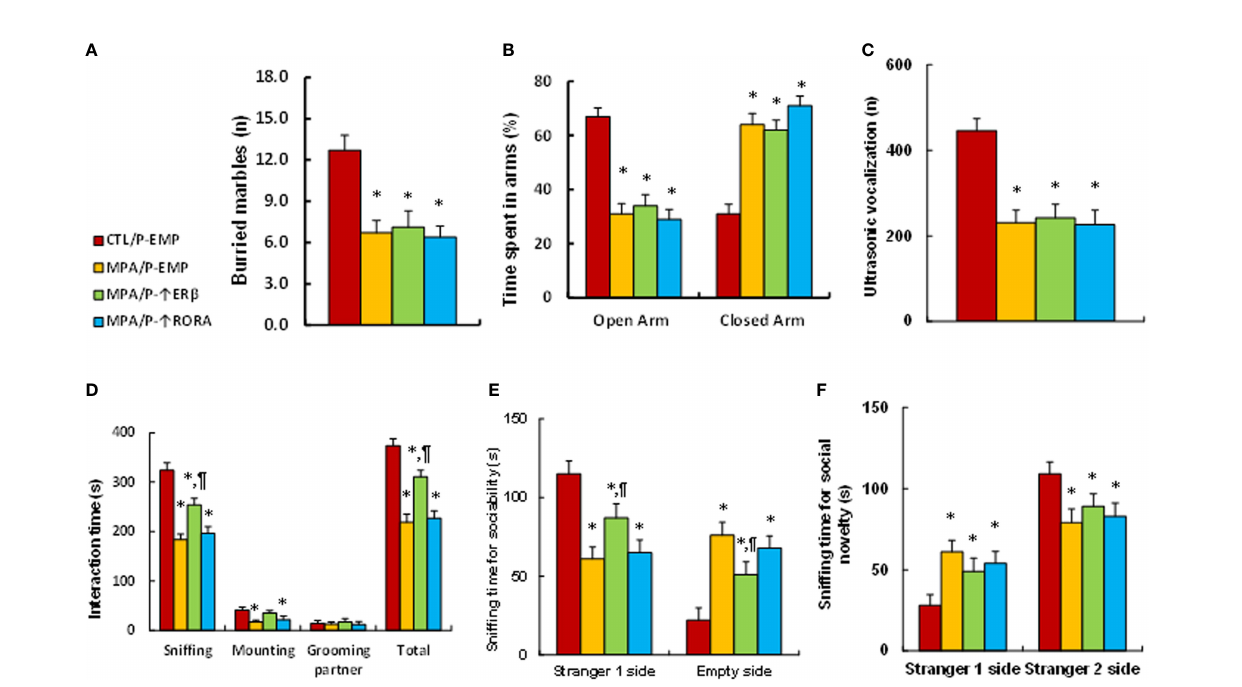
FIGURE 6 | Postnatal ER b expression partly ameliorates prenatal MPA exposure-mediated social de fi cits in mouse offspring, while postnatal RORA expression has no effect. The pregnant dams were treated with either control (CTL) or MPA, and the subsequent offspring received empty (EMP), ER b ( ↑ ER b ) or RORA ( ↑ RORA) lentivirus before then being used for animal behavior tests. (A) MBT tests, n=9. (B) EPM tests, n=9. (C) Ultrasonic vocalization, n=9. (D) Social interaction (SI) test, n=9. (E, F) Three-chambered social tests for sociability (E) and social novelty (F) , n=9. * P < 0.05, vs. CTL/WT group; # P < 0.05, vs. CTL/OXT-/- group. Data were expressed as mean ±